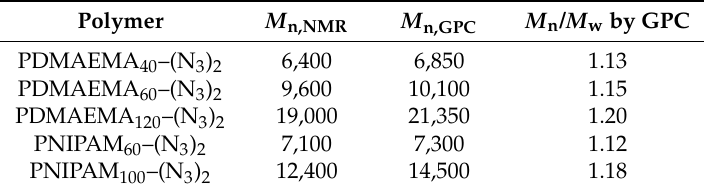
Figure 3. The 1 H-NMR spectra of P(DMAEMA- co -ProA) ( upper ) and P(NIPAM- co -ProA) ( lower ) in CDCl 3 .